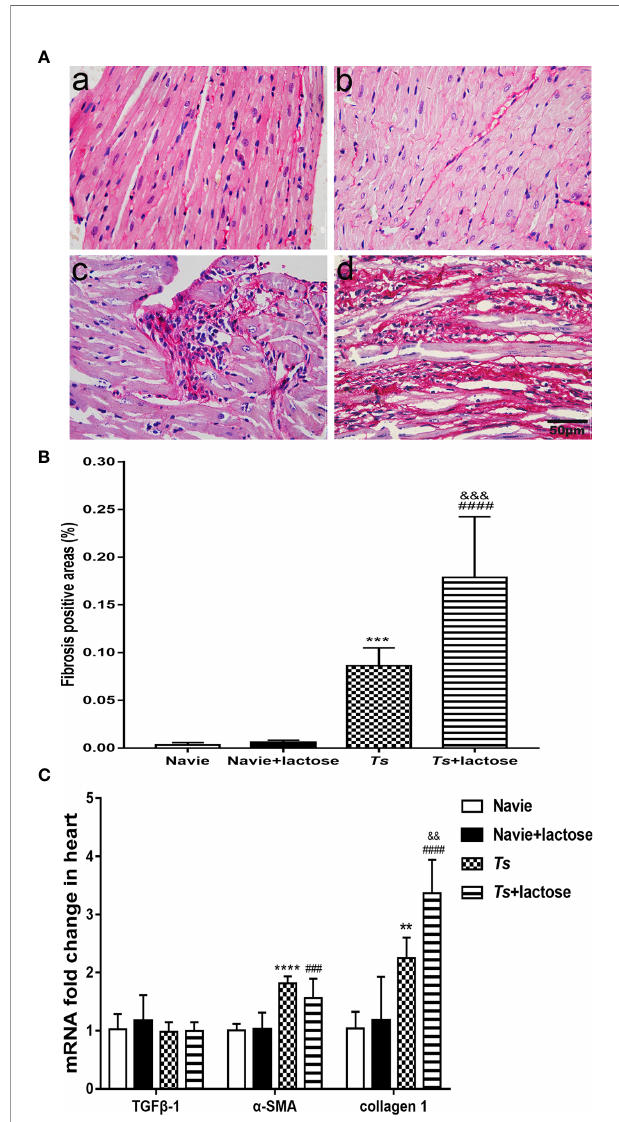
FIGURE 2 | Cardiac fi brosis and mRNA levels of TGF b -1, a -SMA, and collagen 1 in the hearts of different groups of mice. (A) Cardiac fi brosis. No obvious fi brosis was observed in the heart tissues of uninfected mice (a) and uninfected mice with a -lactose treatment (b); severe fi brosis was observed in the heart tissues of T. spiralis -infected mice (c) and T. spiralis -infected mice with a -lactose treatment (d). Original magni fi cation 400× (scale bar = 50 µm); sirius red stain. (B) Quantitative analysis of fi brosis areas in the heart. The positive area of fi brosis was expressed as percentage. (C) The mRNA expression levels of TGF b -1, a -SMA, and collagen 1 in the heart. Data are presented as means ± SD; there were eight mice in each group and the data shown are representative of those from two different experiments. ** P < 0.01, *** P < 0.001, and **** P < 0.0001 vs. uninfected mice. ### P < 0.001